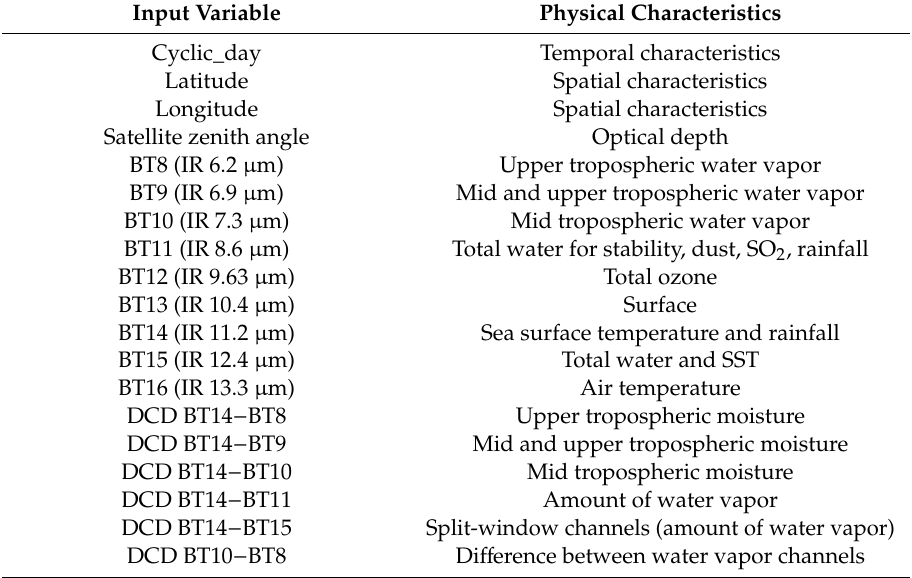
Table 3. Summary of the physical characteristics of input variables in the retrieval models of TPW. Here, each brightness temperature (BT) of channels 8 to 16 are named BT8 to BT16,